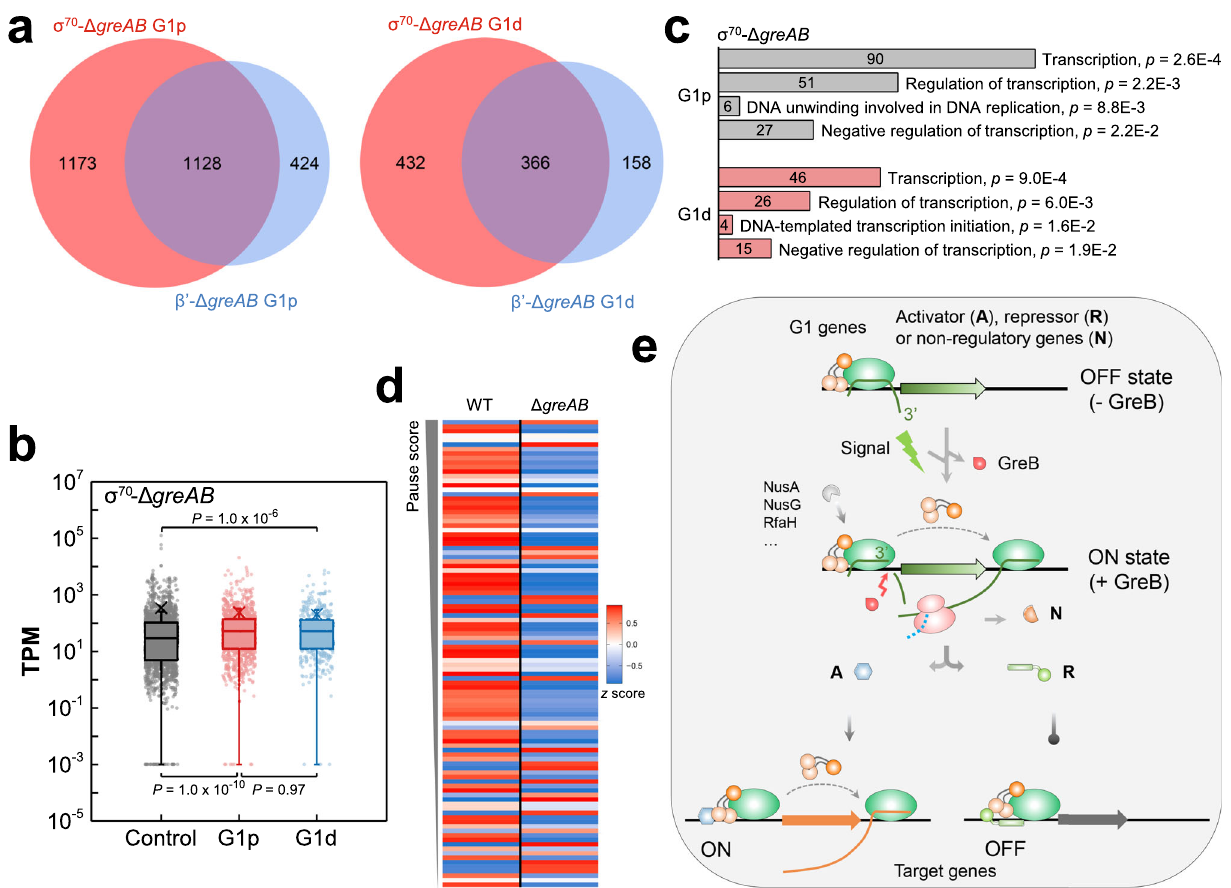
Fig. 6 Role of σ 70 -dependent pauses in transcription regulation. a Venn diagrams of all G1p (left) and G1d (right) pauses from Δ greAB cells identi fi ed in this work. b Boxplot of transcripts per million (TPM) for the genes with and without G1p or G1d pauses. Control genes, n = 1641; genes with G1p pauses, n = 863 and genes with G1d pauses, n = 386. P value was calculated by two-tailed Mann-Whitney U -test. c Gene Ontology (GO) analysis of genes with G1p and G1d pauses in the corresponding promoter-proximal regions. All signi fi cantly enriched gene categories are listed. The number of genes in each category is shown inside the bars. d Heatmap shows the transcription pattern of genes containing G1 pauses in σ 70 -WT and σ 70 - Δ greAB datasets. The G1 genes whose start codon is ≤ 20 bp upstream and ≤ 100 bp downstream from σ 70 - Δ greAB G1 pause sites (pause score ≥ 1000, n = 104) are shown. Data from three biological replicates are presented. WT, σ 70 -WT strain; Δ greAB , σ 70 - Δ greAB strain. e Schematic illustration of the mechanism for σ 70 -induced promoter-proximal pausing, its suppression by GreB, and the impact of the pausing on global regulation of transcription. σ 70 induces strong backtracked G1 pauses to inhibit gene transcription by hindering RNAP elongation. The GreB expression is increased under certain environmental stresses to relieve the G1 pauses. The release of G1 pauses increases the corresponding genes transcription, especially the genes coding for transcription regulators. The transcription regulators further up- or down-regulate transcription of target genes to response to environmental